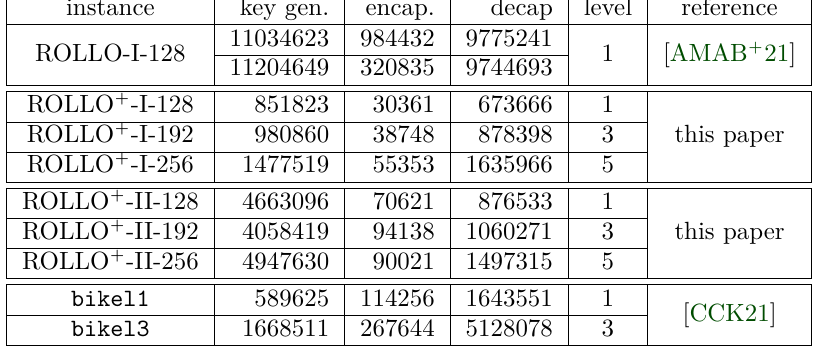
Table 4: Cycle counts for key generation, encapsulation, and decapsulation of the ROLLO-I implementations from [AMAB ` 21] (the paper did not implement ROLLO-II), our ROLLO ` implementation, and the BIKE implementation from